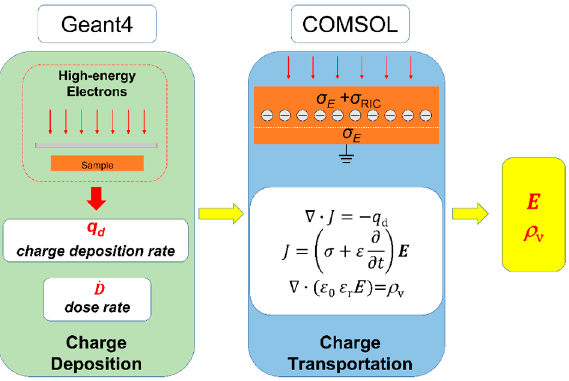
Figure 5. Joint simulation method of internal charging based on Geant4 and COMSOL.